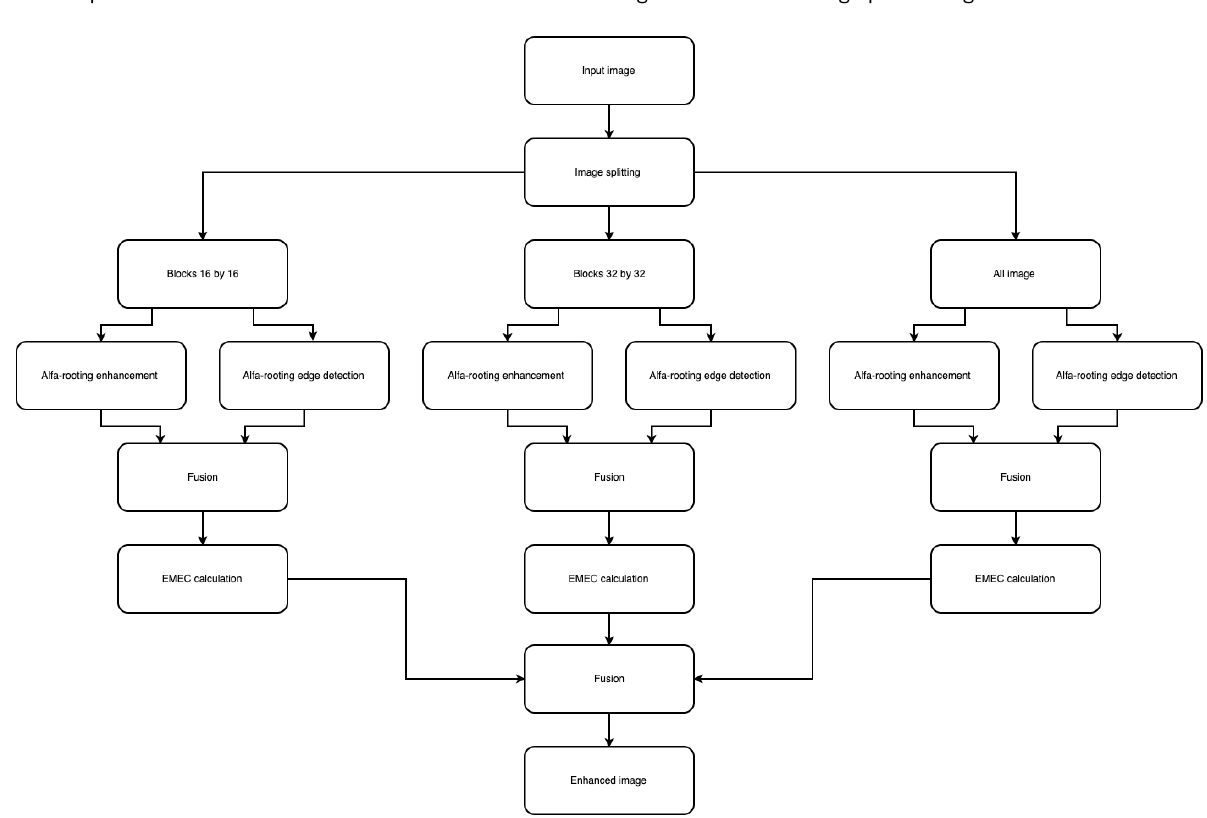
Fig. 1. Block diagrams of the proposed enhancement algorithm.